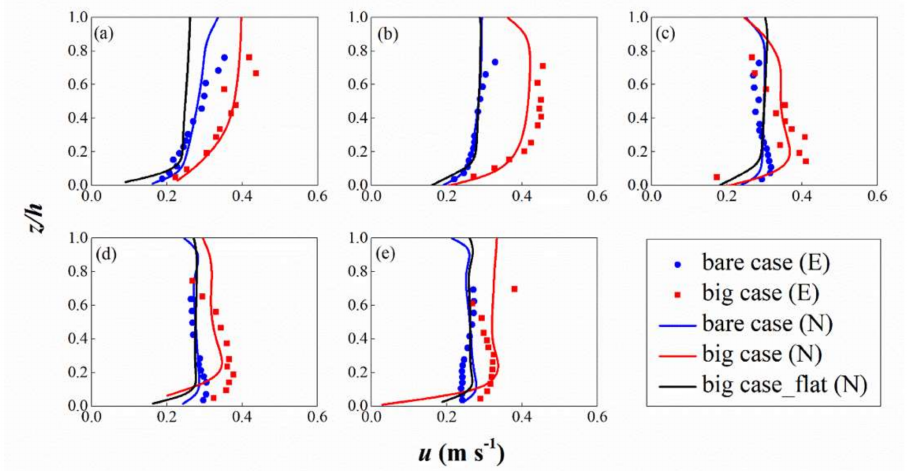
Figure 8. Comparisons of simulated and measured longitudinal velocity profiles on 5 cross sections: